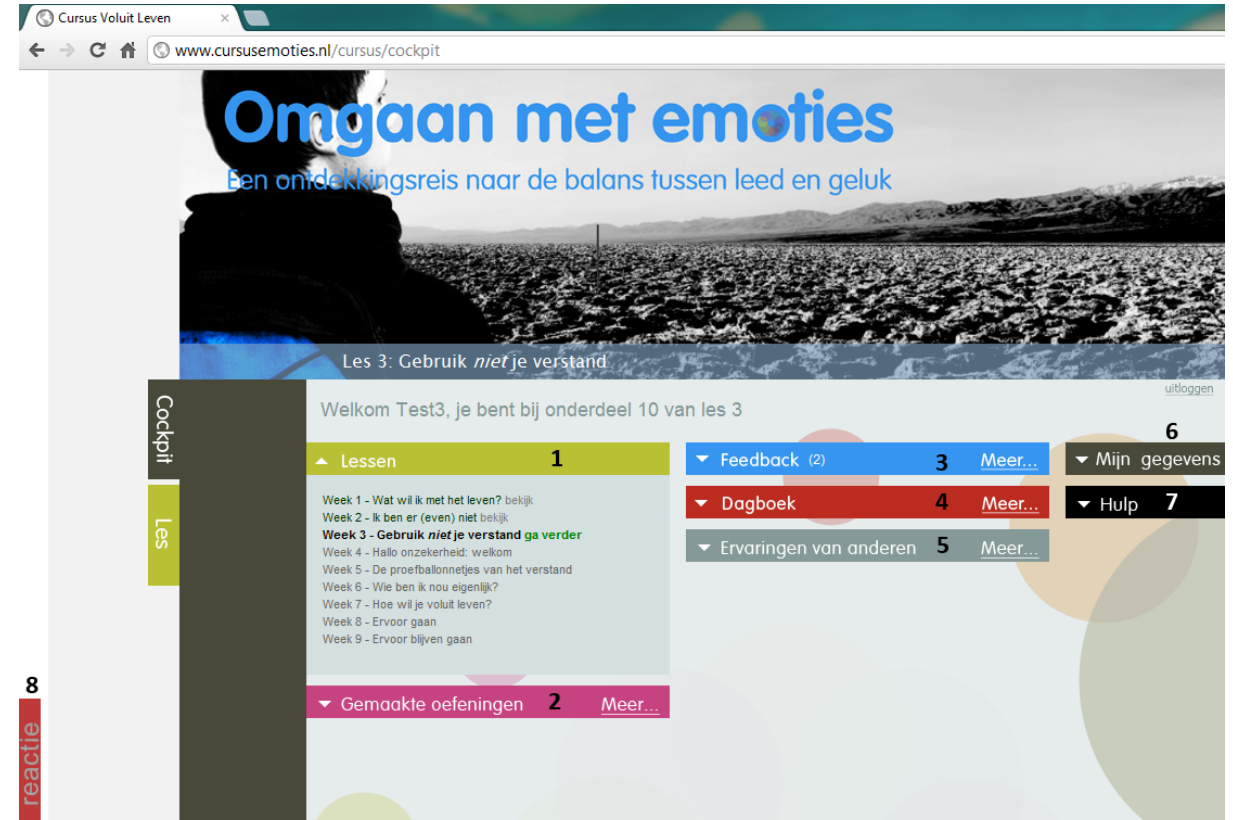
Figure 1. Personal home page of the Web-based intervention with the elements included for all